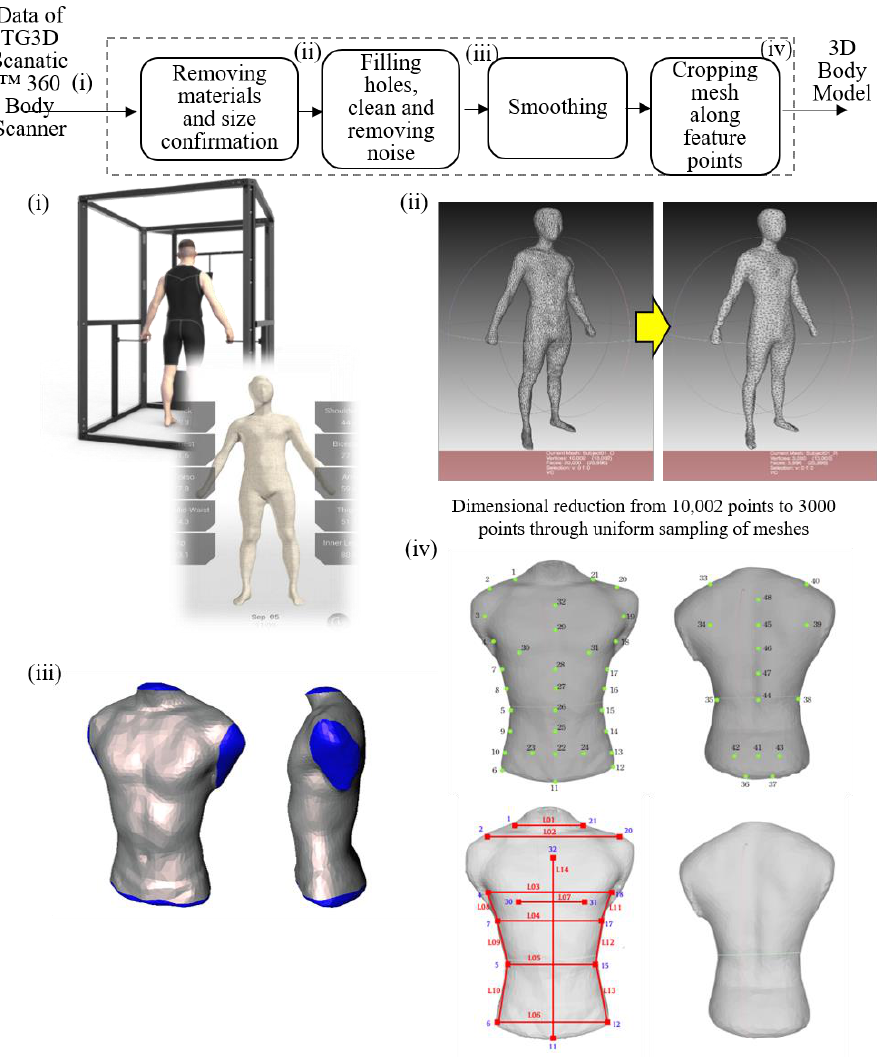
Figure 4. Illustration for postprocessing procedure of 3D human body geometry.